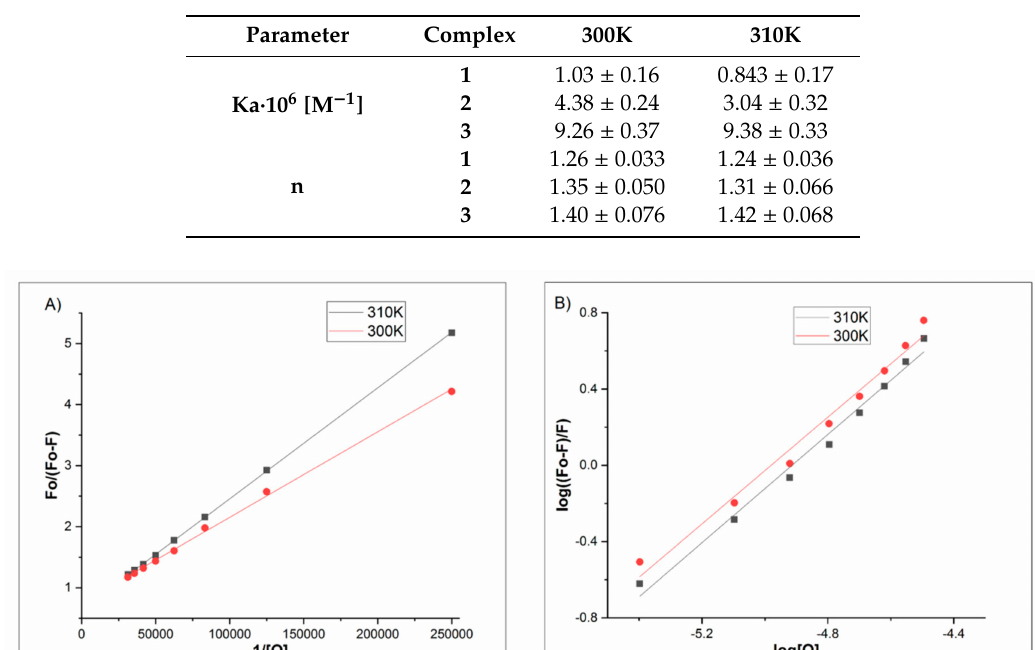
Table 4. The binding parameters of the apo-Tf-Cu systems.